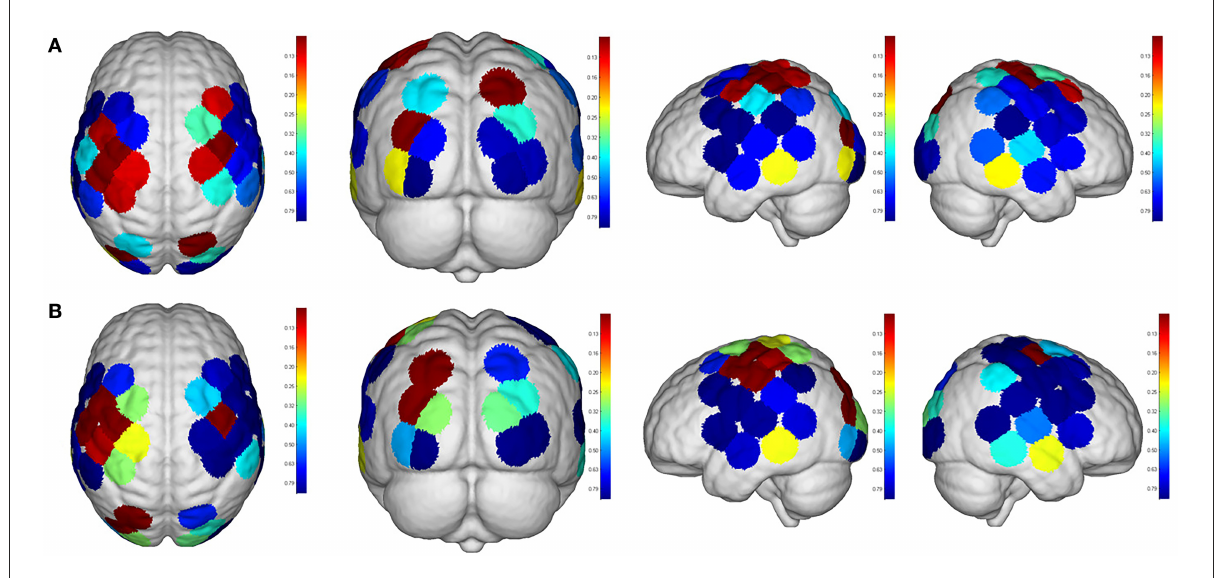
FIGURE9 Comparisons of cortical activation between R2 and R3. R2: motor imagery (MI) mode; R3: passive mode; (A) : β value; (B) : featured value; color bar: 0.1 to